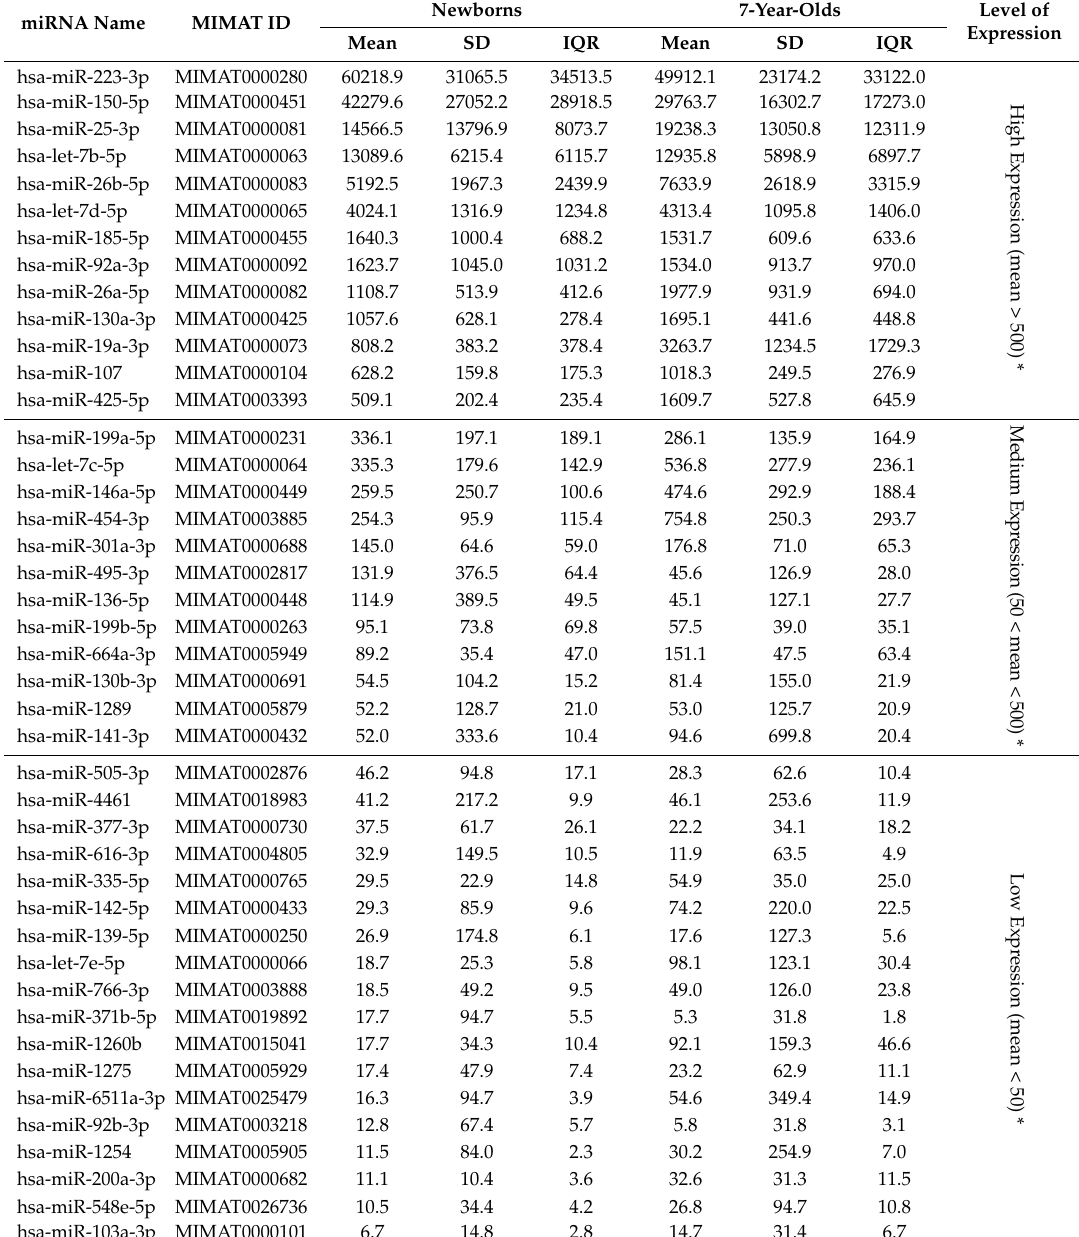
Table 2. Distributions of microRNA (miRNA) expression (counts) in newborns and 7-year-old children. miRNA